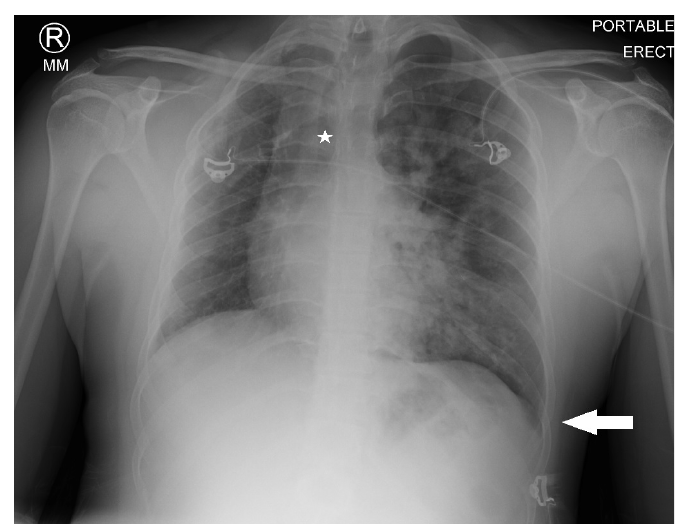
Image 1. An anteroposterior plain film of the chest revealing a deviated trachea (star) and a deep sulcus sign (arrow), in addition to fluffy infiltrates in the left lung